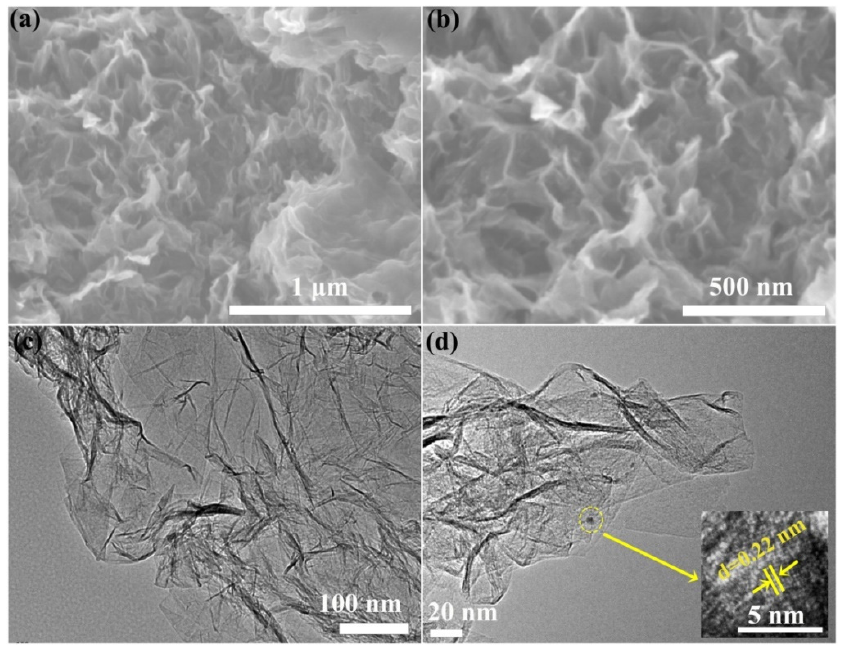
Figure 2. ( a , b ) SEM, ( c ) TEM and ( d ) HR-TEM images of Pd/rGO-0.5%. (The inset is enlarged view of the area circled in yellow of d.) of the area circled in yellow of ( d